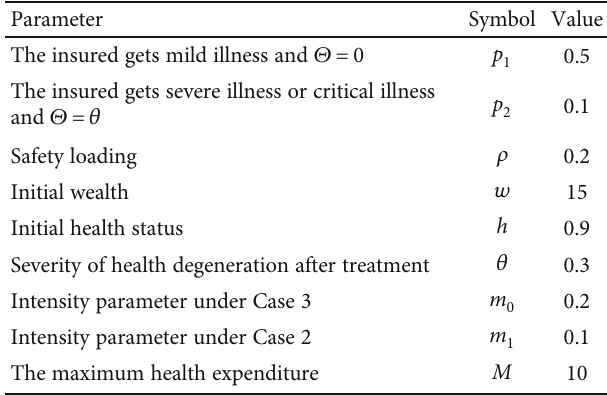
Table 1: Parameter values for the illustration